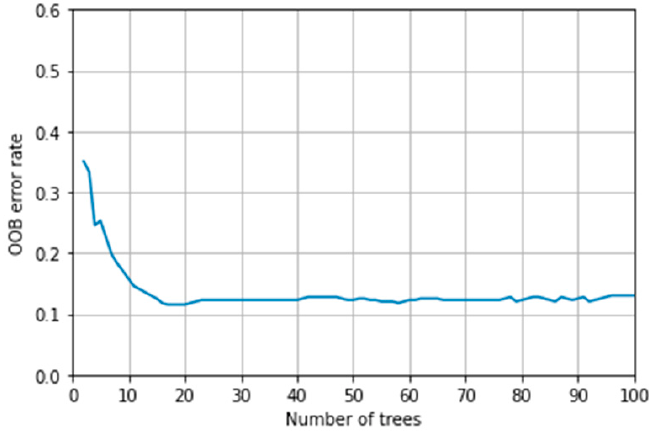
Figure 14. Out-of-bag (OOB) error rate vs. number of trees.